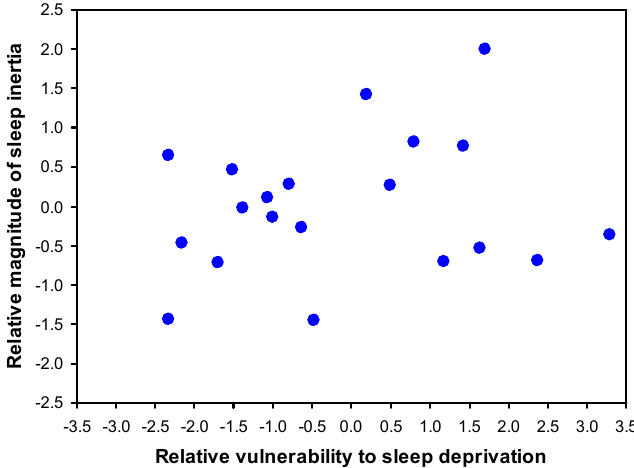
Figure 7. Comparison of interindividual differences in susceptibility to sleepiness due to SI and vulnerability to sleepiness during total sleep deprivation. The ordinate shows individual estimates of the magnitude of SI, relative to baseline sleepiness, expressed as difference from the group mean. The abscissa shows individual estimates of the effect of sleep deprivation, relative to baseline sleepiness, expressed as difference from the group mean. Both are in units on the KSS. Notice that the variability between individuals in the effect of SI on sleepiness is only somewhat smaller than the variability between individuals in the impact of sleep deprivation on sleepiness—however, the two effects are not significantly related within individuals.